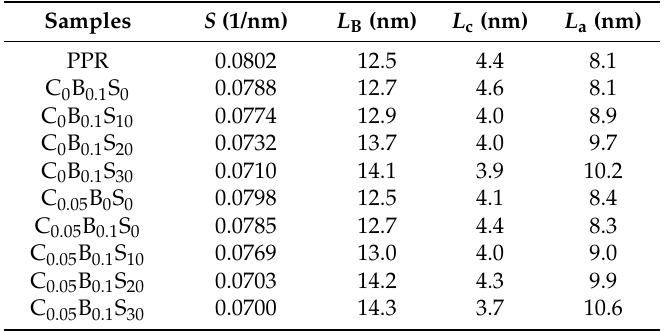
Figure 6. 2D-SAXS patterns of the PPR and its blends (Color bar represents Scattering Intensity). Table 4. The parameters of lamellar structures of PPR and its blends.